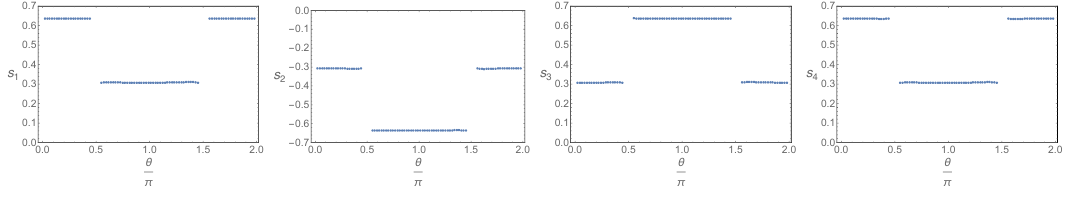
Figure 8 . The eigenstates ( s 1 , s 2 , s 3 , s 4 ) T of G − 1 (0 ,~k ) as a function of θ/π along the enclosed loop with negative energy eigenvalues. Note that momentum is parameterized in (4.1). The sudden jump appears in all the four components of eigenstates s